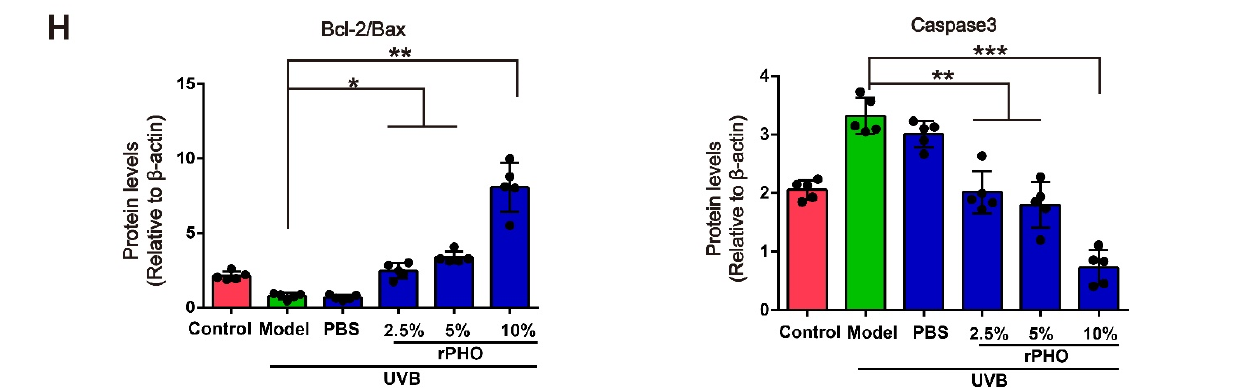
Figure 6. Photolyase significantly inhibited UVB-induced oxidative stress and inflammatory responses in mice. ( A ) Lipid peroxidation in the dorsal skin in each group after rPHO treatment was measured by quantifying malondialdehyde (MDA). ( B ) SOD activity in the dorsal skin after rPHO treatment. ( C ) GSH-Px activity in the dorsal skin after rPHO treatment. ( D – F ) Expression of IL-6, IL-1 β , and TNF- α in skin was measured. mRNA relative levels were normalized to Gapdh levels. ( G ) Expression of caspase 3, Bcl-2, and Bax protein examined by western blotting. ( H ) Semi-quantification analysis of ( G ) by ImageJ. Data are expressed as means ± SD ( n = 5). * p < 0.05, ** p < 0.01, *** p < 0.001.